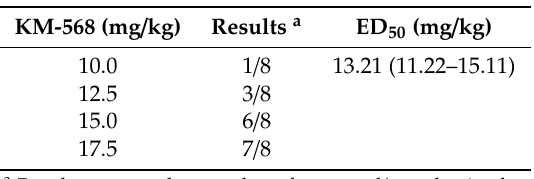
Table 3. Results of tests performed in Frings mice after 0.25 h of intraperitoneal administration of compound KM-568.